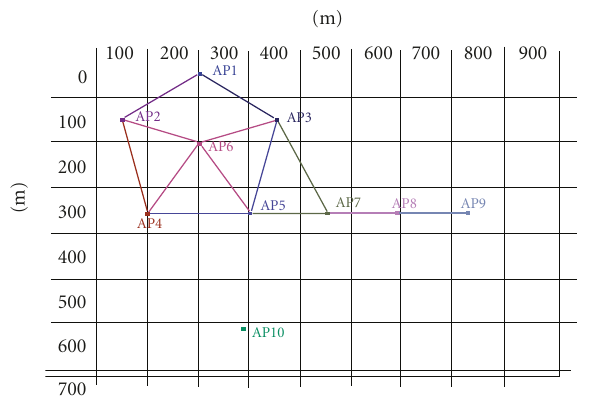
Figure 12: Scenario used for evaluation purposes.